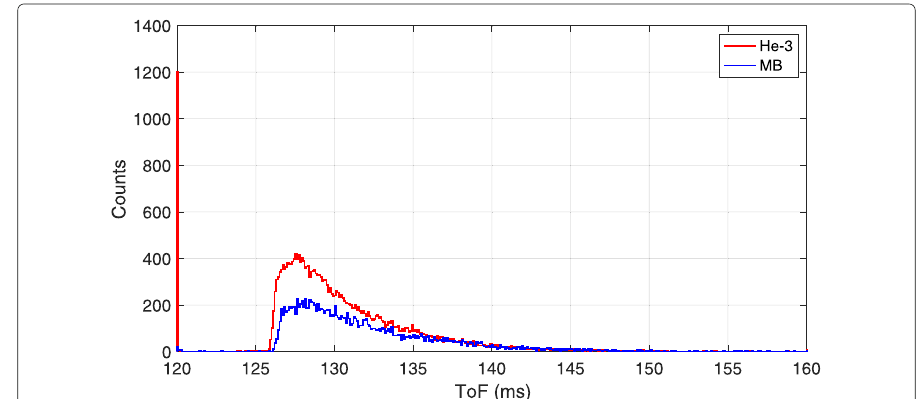
Fig. 16 ToF spectrum obtained with the Multi-Blade detector (blue line) and the 3 He-tube (red line) for ToF = 120 - 160